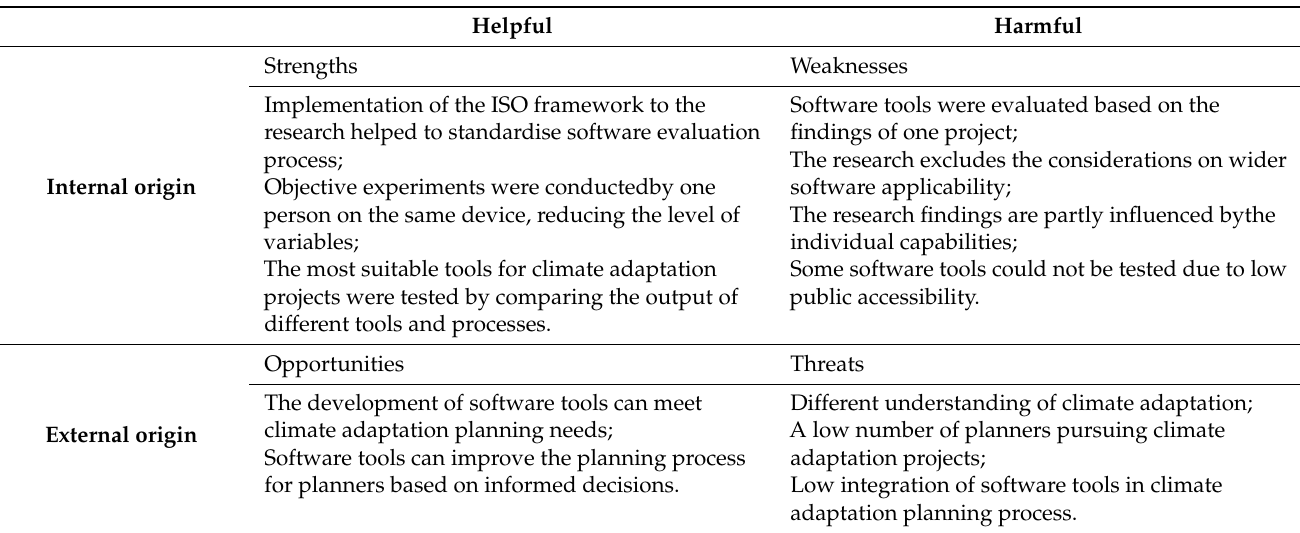
Table 7. SWOT analysis (source: